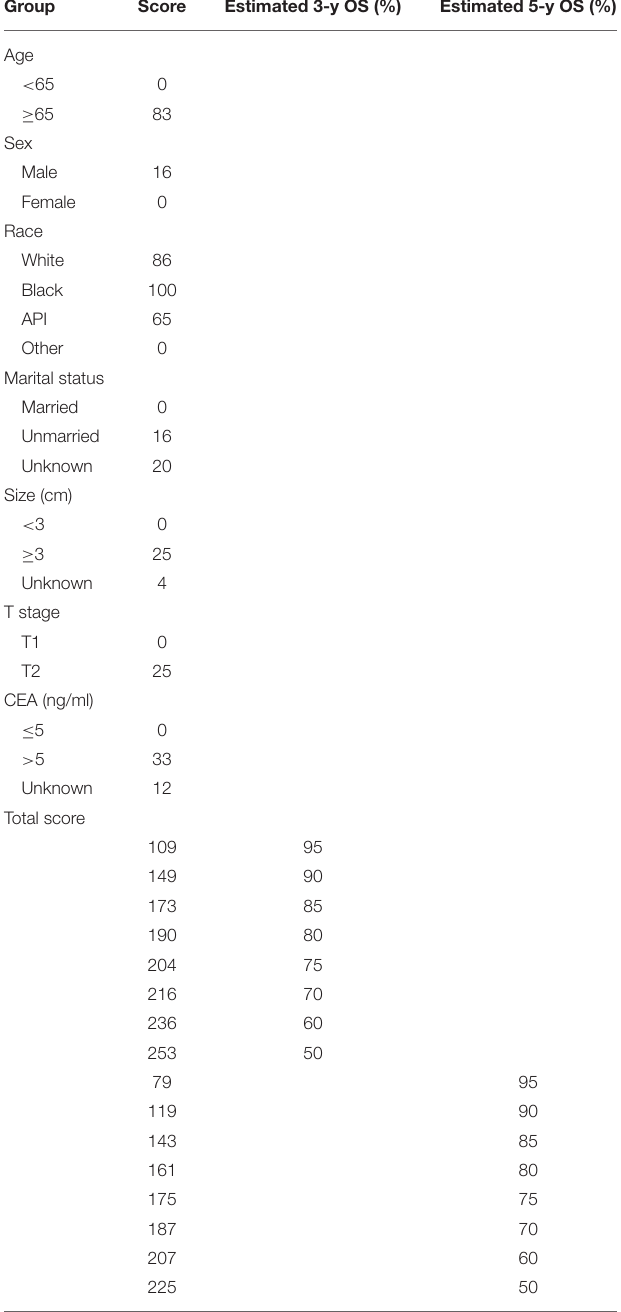
TABLE 3 | Point assignment of each component and prognostic score for stage I rectal cancer. Group